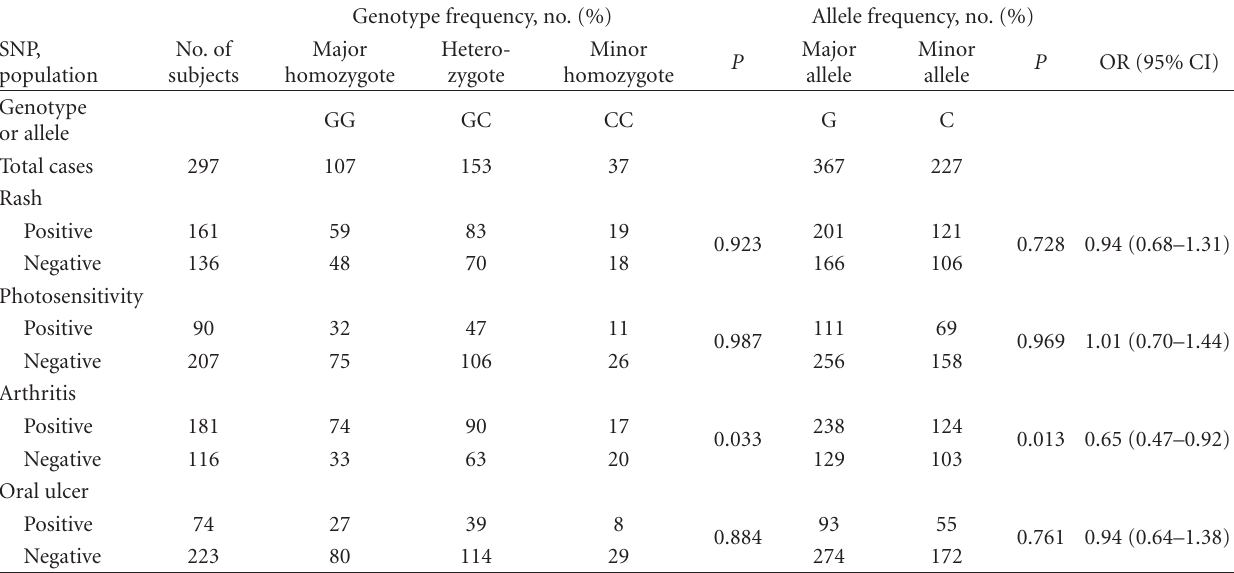
Table 2: Association of IL-12b SNP rs6887695 with clinical symptoms in SLE patients ∗ . Genotype frequency, no. (%) Allele frequency, no. (%)